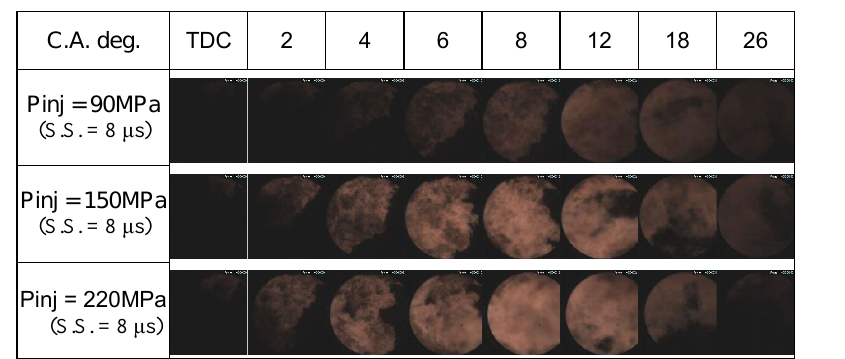
Fig. 16. High speed flame photos with borescope by changing Pinj at EGR rate 50%